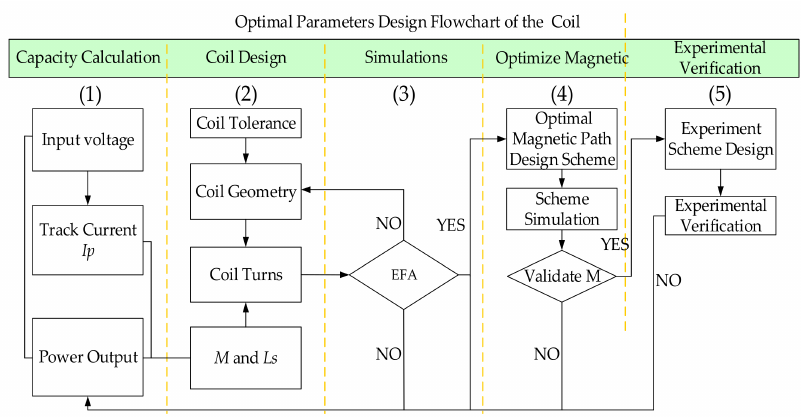
Figure 8. Design flowchart of the IPT system.